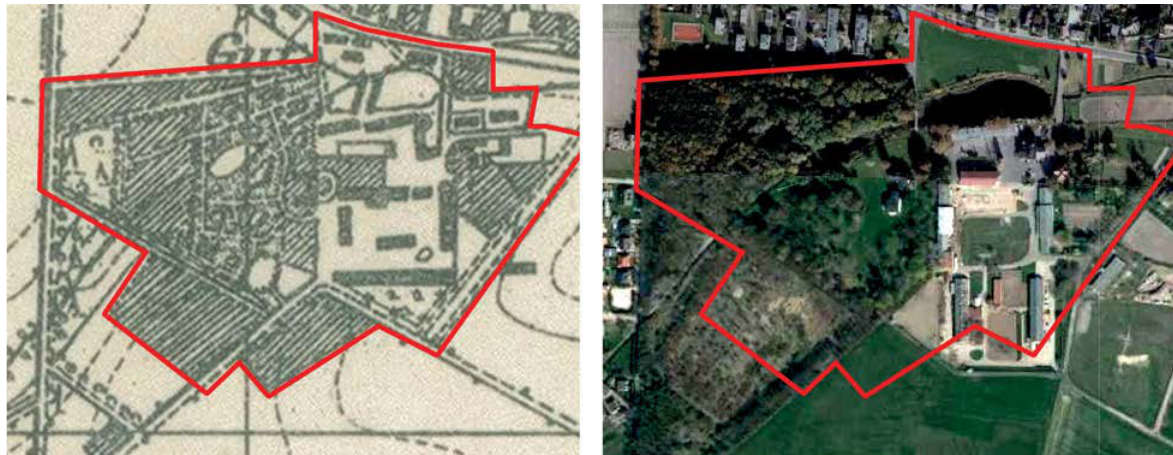
Fig. 7. Legible spatial arrangement of the manorial and grange complex in Swadzim on a map issued in the 1940s and on a contemporary orthophoto map, marked with a red line. Source: own compilation based on http://mapy.amzp.pl;